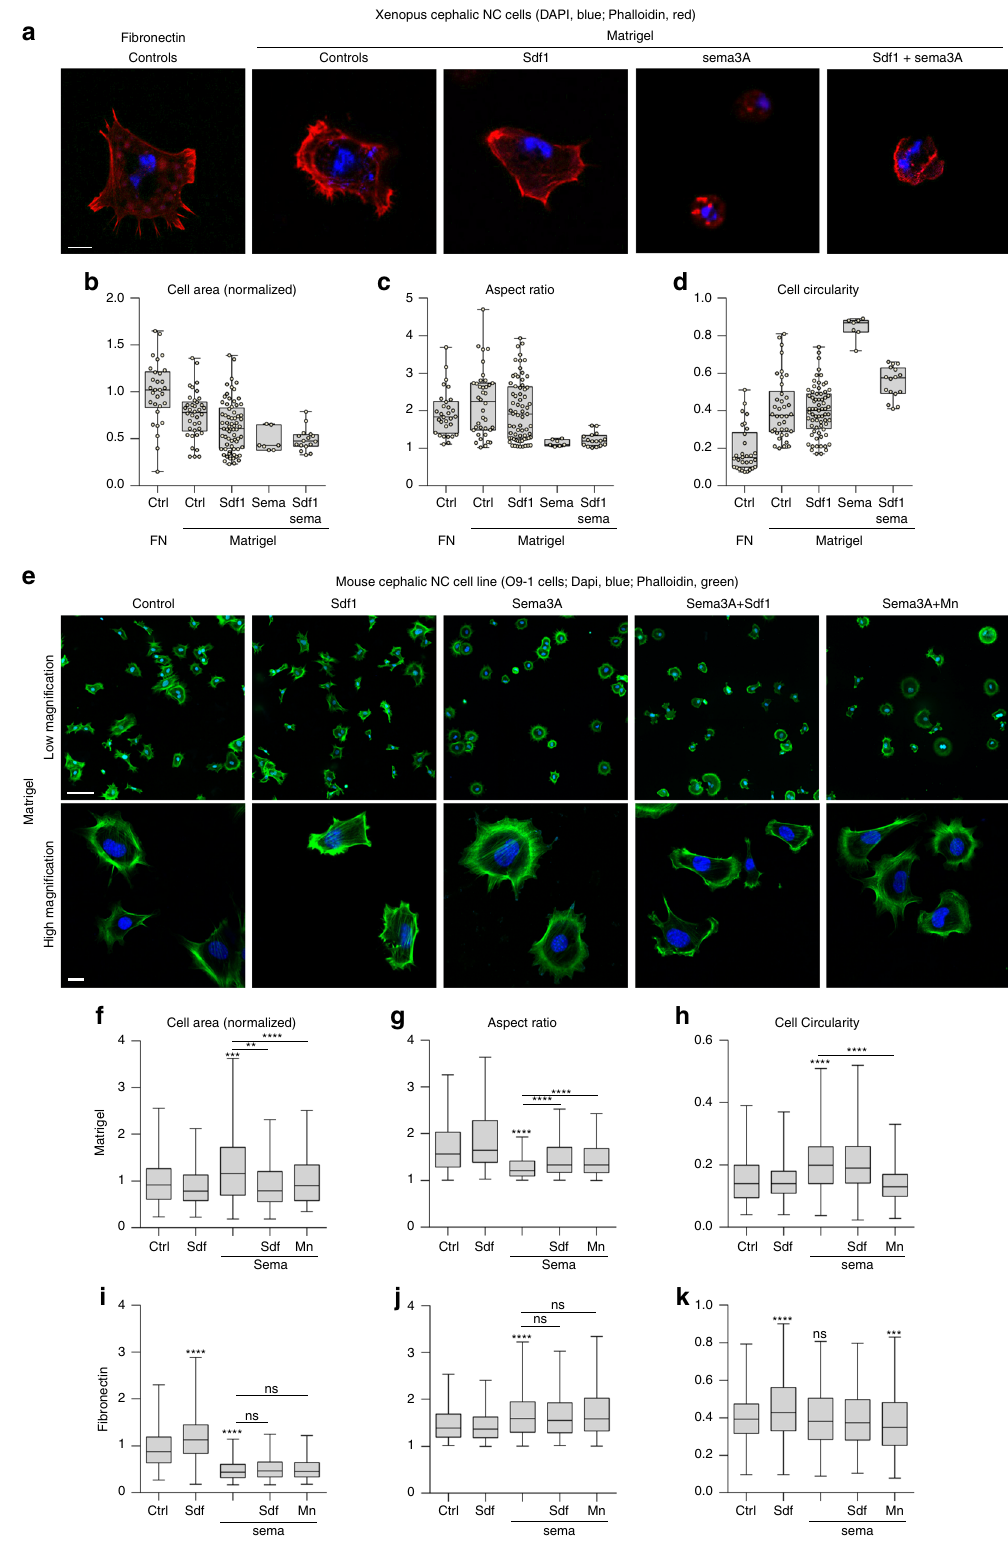
reduced the aspect ratio (Fig. 8g) indicating that cells were less polarised. The actin cytoskeleton was organised as a large circle surrounding the nucleus (Fig. 8e) instead of being accumulated on one side of the cell with fi laments in protrusions, as seen in control conditions. Interestingly, adding Sdf1 or Mn 2 + was suf fi cient to rescue spreading (Fig. 8f), aspect ratio (Fig. 8g)